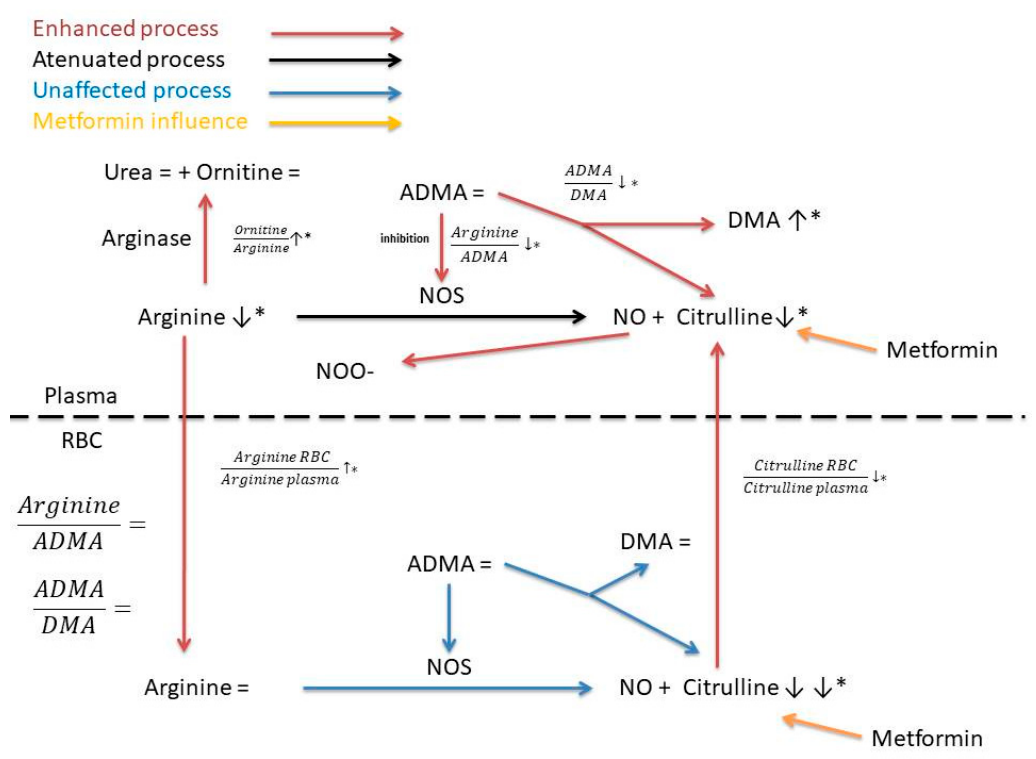
Figure 6. Nitric oxide metabolism alteration in different compartments. Abbreviations: ADMA: asymmetric dimethylarginine; DMA: dimethylamine; NOS: nitric oxide synthase; NO: nitric oxide RBC: erythrocyte SDMA: symmetric dimethylarginine. *- p < 0.05 vs. control